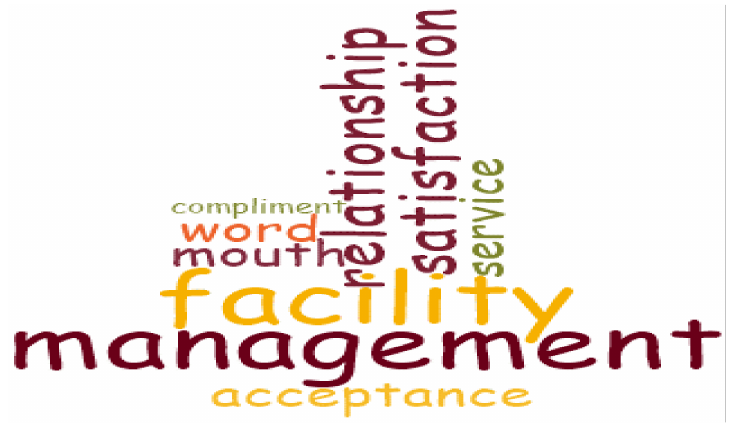
Figure 6. Word cloud for user post-feedback behaviour